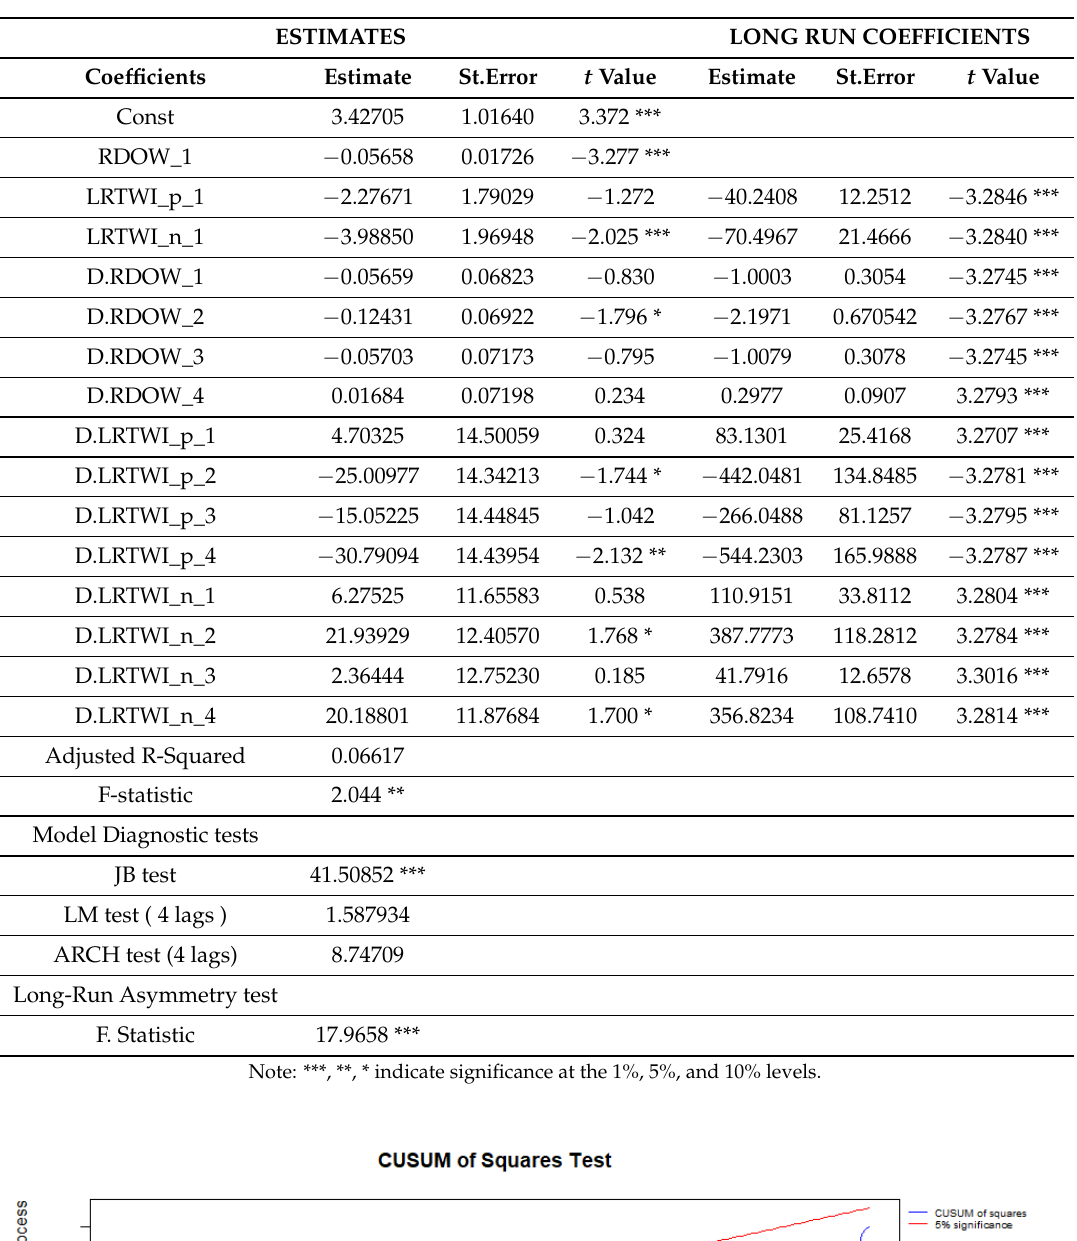
Table 4. Nonlinear autoregressive distributed lag (NARDL) analysis.